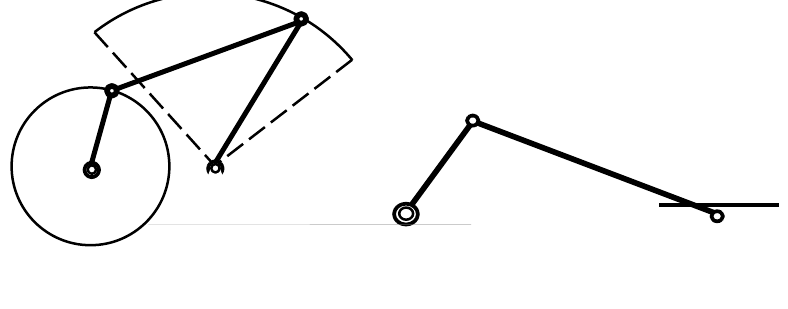
Fig. 1. Mechanisms considered in the project